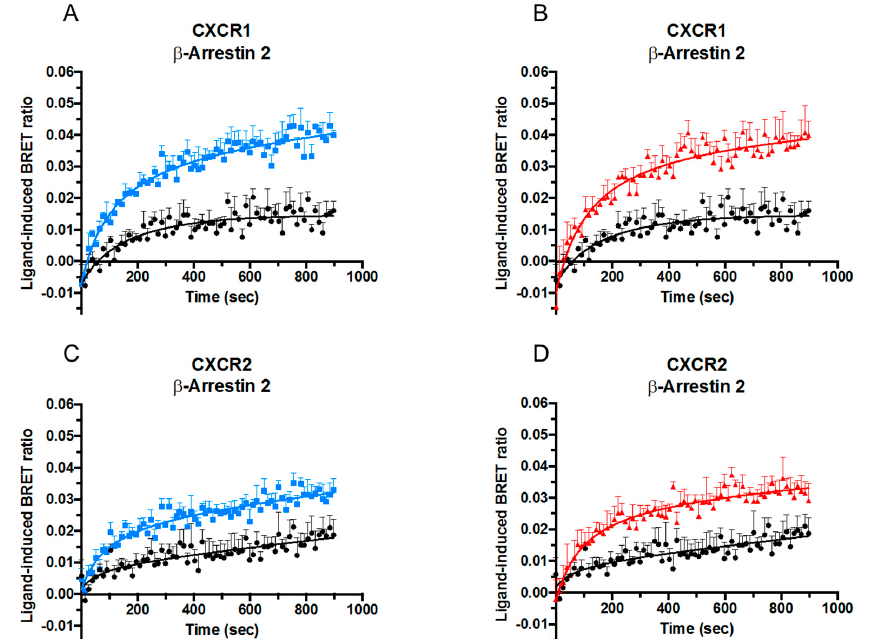
Figure 4. Effects of NH 2 -terminal processing on CXCL8-induced β -arrestin 2 recruitment. Kinetic BRET measurements of β -arrestin 2 recruitment to CXCR1 ( n = 3) ( A , B ) and CXCR2 ( n = 3) ( C , D ) in transfected HEK-293T cells after stimulation with 100 nM CXCL8(1-77) ● ,[Cit 5 ]CXCL8(1-77) ■ or CXCL8(6-77) ▲ . Results are represented as ligand-induced BRET ratio +SEM.